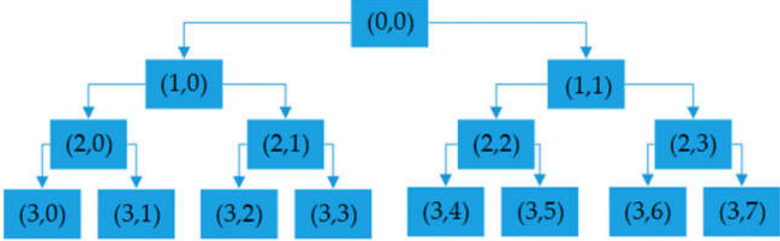
Figure 3. Schematic diagram of 3-layer wavelet packet decomposition .